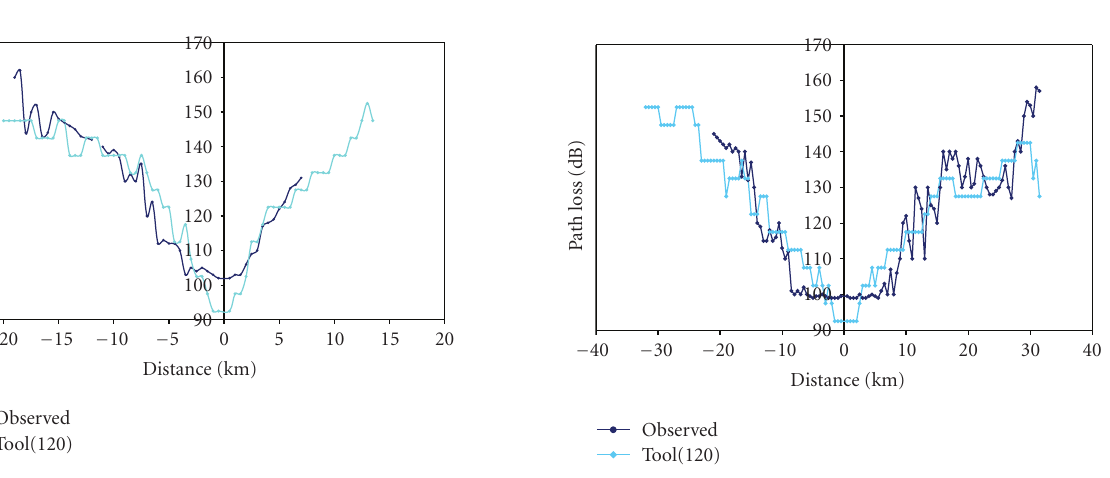
Figure 11: Comparison of tool predicted losses with observed losses versus track distance for Talegaon base station.